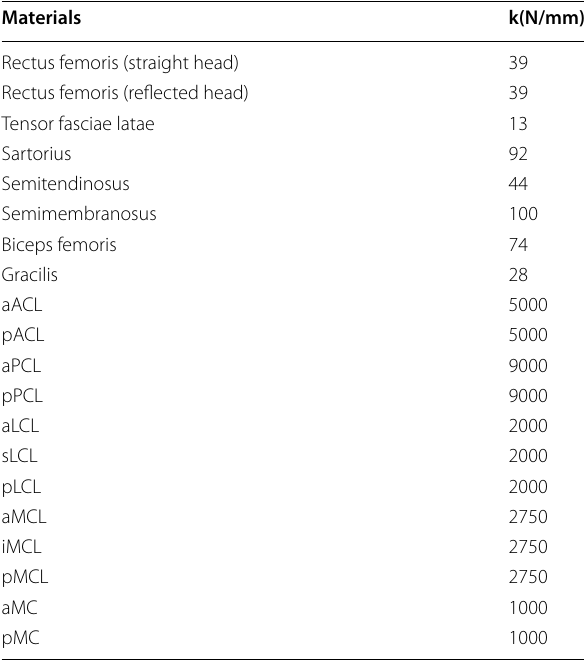
Table 2 Properties of the muscles and ligaments